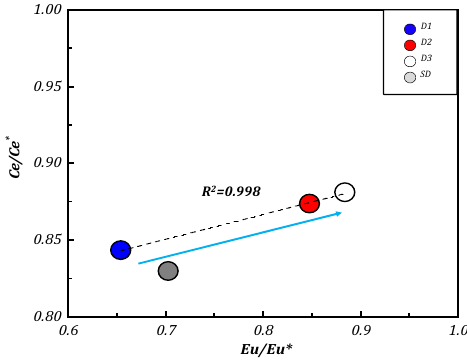
Figure 7. Cross-plot of Ce/Ce* vs. Eu/Eu* values of different types of dolomites in the Xixiangchi Formation. The Ce/Ce* and Eu/Eu* values of the SD dolomites were not used for correlation analysis. Note the Ce/Ce* and Eu/Eu* values of some of D1, D2, and SD samples have been previously reported by Liang et al. [45]. See Table S3 for details.